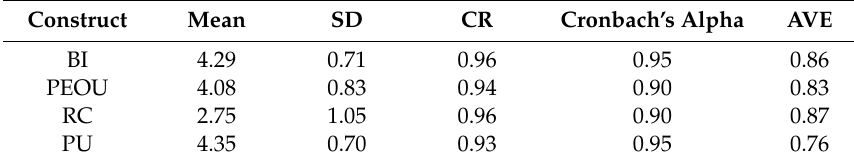
Table 3. Descriptive statistics of the criteria for the quality of the